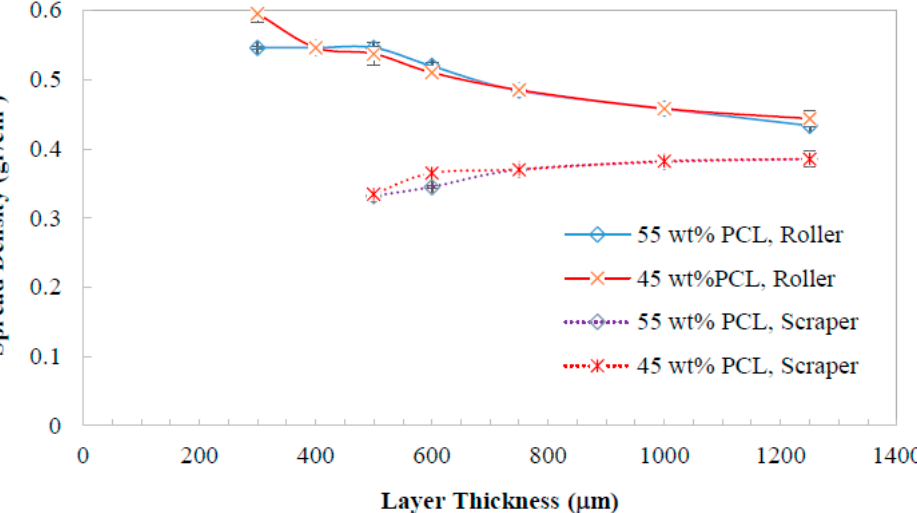
Figure 4. The variation of the powder bed density when using two spreading tools, the scraper and press rolling method, for different layer thicknesses.